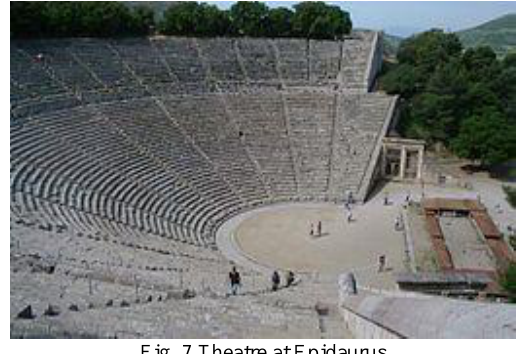
Fig. 7 Theatre at Epidaurus